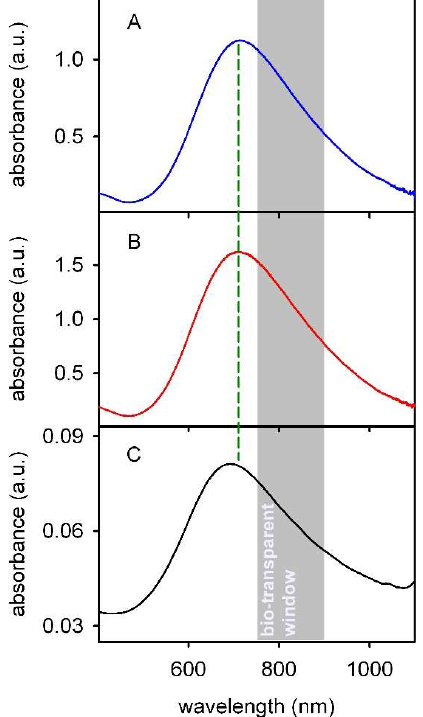
Figure 2. Absorption spectrum of PBnp. ( A ) solution, prepared from Fe 3+ and [Fe II (CN) 6 ] 4- ; ( B ) solution, prepared from Fe 2+ and [Fe III (CN) 4 ] 3− ; ( C ) dry (air interface) self-assembled monolayer on glass, prepared using PBnp with the absorption spectrum ( A ). The green dotted line evidences the position of the maximum of absorption. The grey area highlights the ‘bio-transparent’ region of the spectrum. (Authors’ graphical rework from data of Ref. [10]).